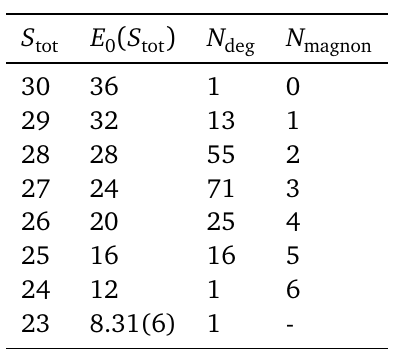
Table 3: Values of the lowest energy for total-spin values close to full saturation = 30), as well as the corresponding degeneracies. Using SU(2) symmetries, ( S tot we have set the S quantum number rather than explicitly ramping up a magnetic tot = 29, there are 13 linearly independent ways to place one localized field. For S tot magnon on the 6 squares and 8 hexagons (see Eq. 5). For each downstep of S , tot the number of magnons increases by one, the energy decreases linearly, while the number of combinations grows rapidly and peaks at “half-filling” or 3 magnons. For = 24, there is just one combination of arranging the 6 magnons by placing them S tot on all the squares. The effect stops at that point, as can be seen from the deviation = from the linear behaviour of the energy at S tot